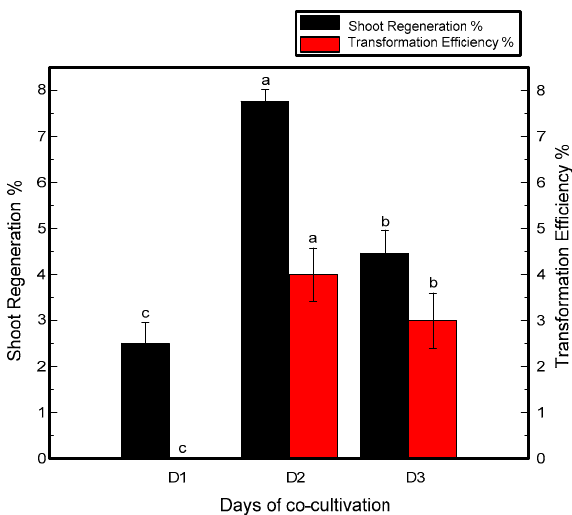
Figure 1. Relation of cocultivation period with shoot regeneration and transformation efficiency of Jinba. Black columns represent shoot regeneration percentage, red columns represent transformation efficiency percentage. Explants were cocultured for 1, 2 and 3 days. Three biological replicates were used. Error bars represent ± SD. a, b, and c are statistically significant at p ≤ 0.05 by ANOVA on ranks test.